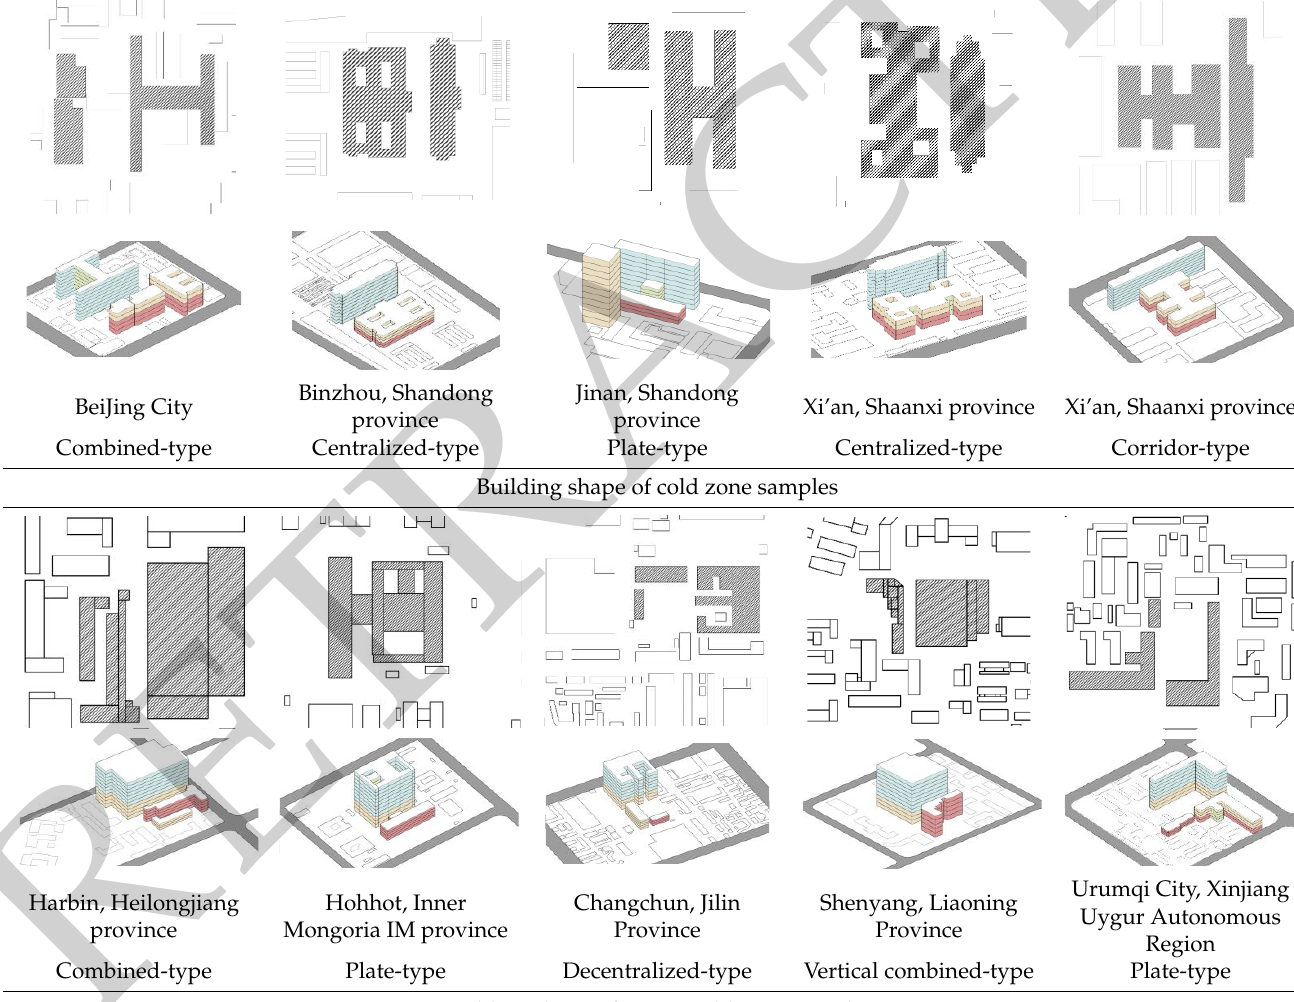
Table 2. Case survey of outpatient buildings in different climate zones of China.